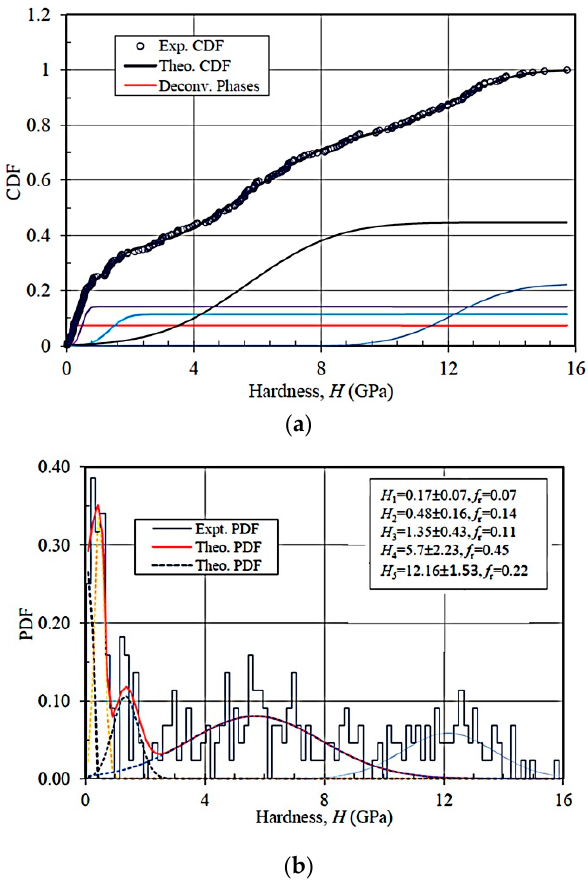
Figure 6. Reduced hardness deconvolution of ANC-1 data ( a ) CDF ( b ) PDF; H i : reduced modulus of phase i ( i = 1: microporosity; i = 2: mixed geopolymer-clay matrix; i = 3: C-S-H; i = 4: nano-crystallites; i = 5: inclusions); f r : volume fraction. Table 3. Hardness of constituent phases obtained from statistical analysis of grid indentation results for three different trials.